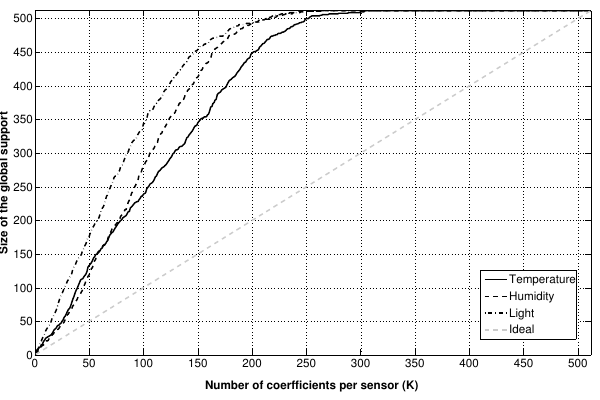
Figure 5. Number of DCTcoefficients necessary to include the K largest coefficients for each signal ( N = 512